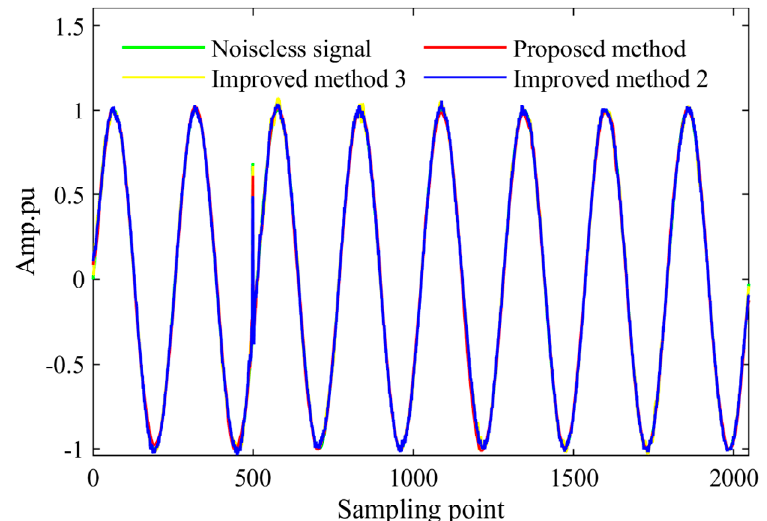
Figure 6. Comparing the denoising impacts of various approaches on an impulsive transient with a 20 dB SNR. Table 1. Denoising effect of various methods on PQDs with a 20 dB